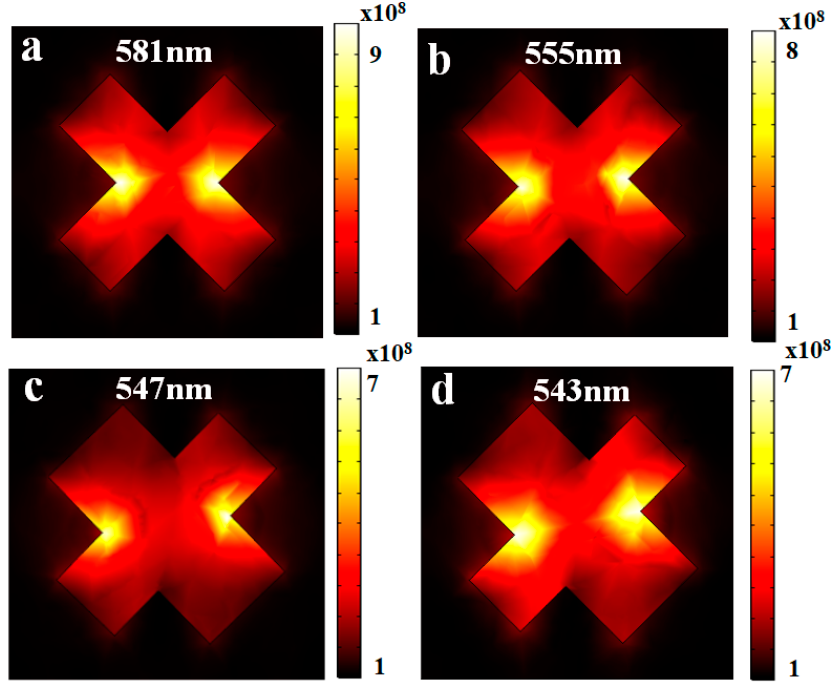
Figure 11. Electric field distribution at wavelengths 581 nm ( a ), 555 nm ( b ), 547 nm ( c ), and 543 nm ( d ) for defective structure d3.